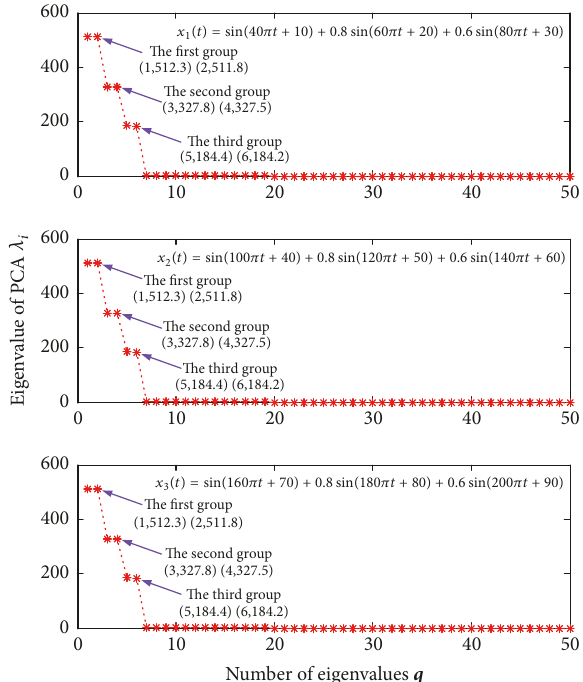
Figure3:Eigenvaluesdistributionofcovariancematrix C withthree frequency